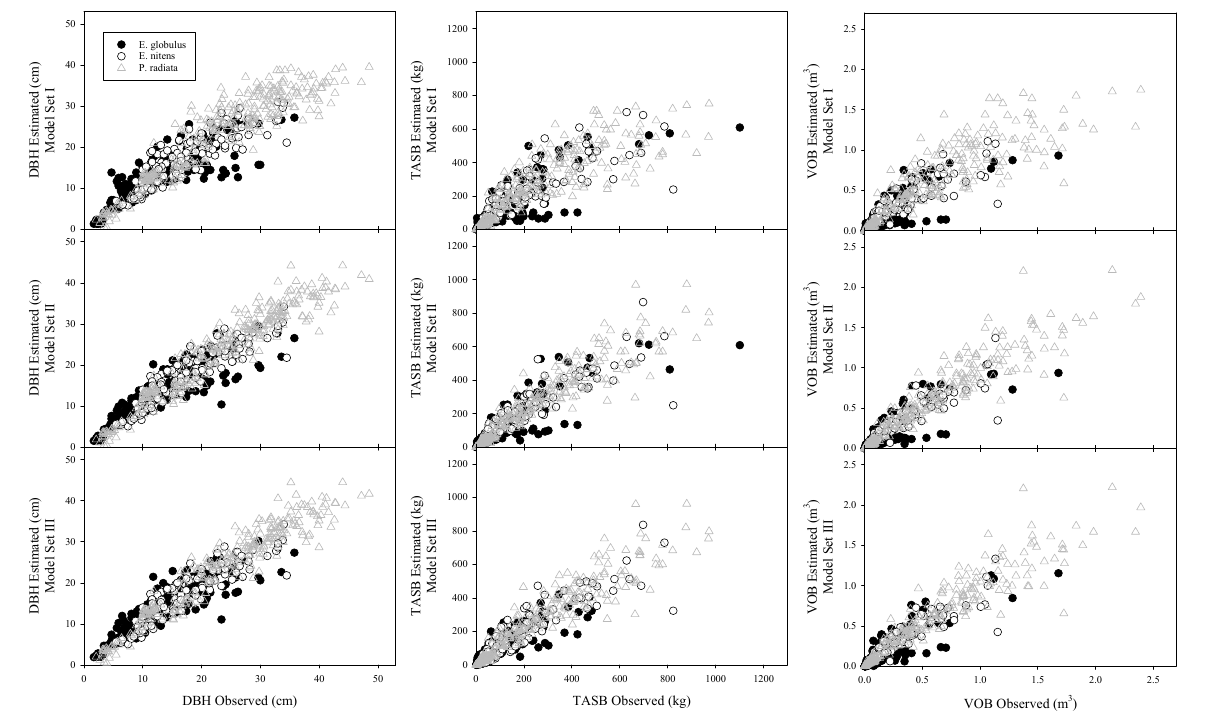
Figure 3. Model evaluation of DBH ( left ), TASB ( center ), and VOB ( right ) models for E. globulus, E. nitens , and P. radiata. Observed vs predicted (simulated) values using model set I ( upper panel ; only HT as independent variable), model set II ( center panel ; HT and CA as independent variables), and model set III ( bottom panel ; HT, CA, and AGE and/or TPH as independent variables). Table 5. Summary of model evaluation statistics using 10-fold cross validation for DBH/biomass/volume estimations for E. globulus, E. nitens , and P. radiata